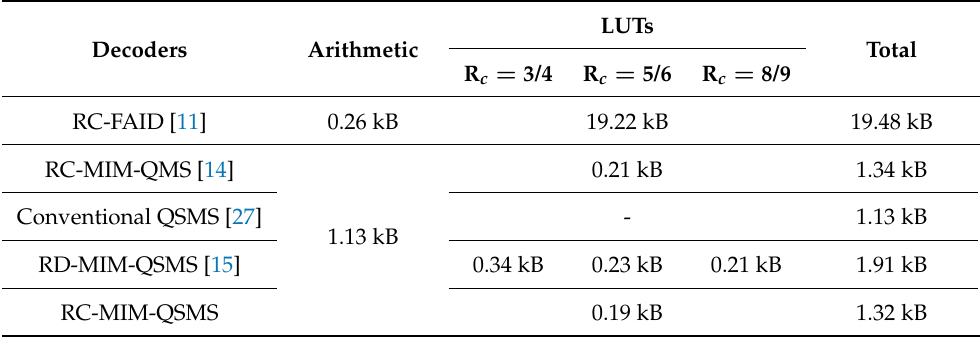
Table 6. The Overall Memory Requirement for Different Quantized Decoders with q m = 4 and T max = 15 for the 5G LDPC